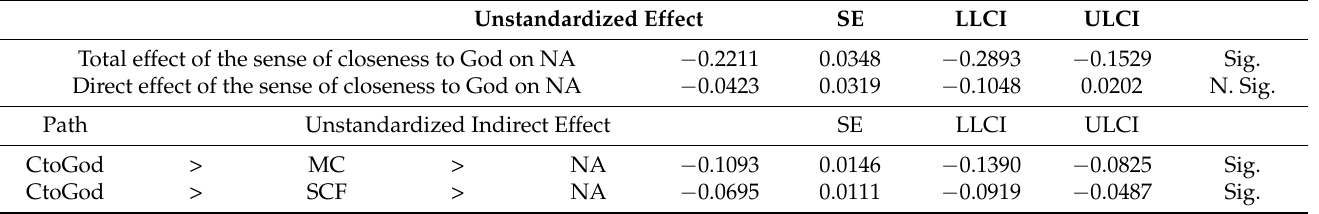
Table 4. Total, direct, and indirect regression analysis on negative